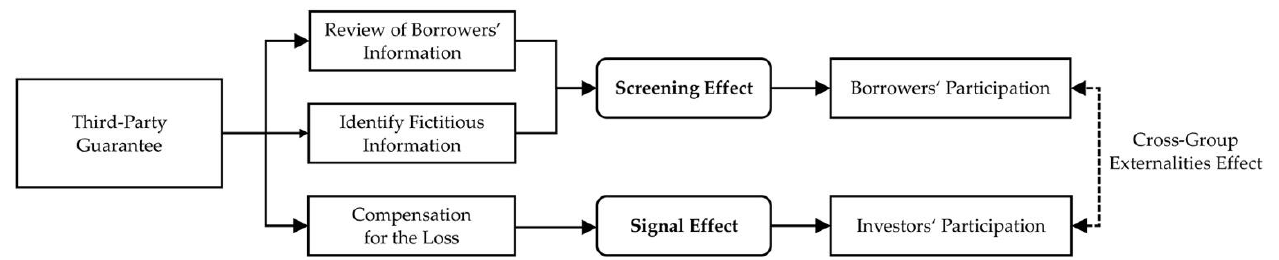
Figure 6. The influence pathway of the third-party guarantee mechanism on platform users’ participation .